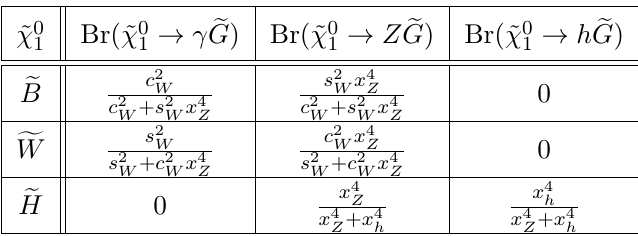
limit ( x 1 ), we find Br( e B → γ e G ) = c 2 I → 1